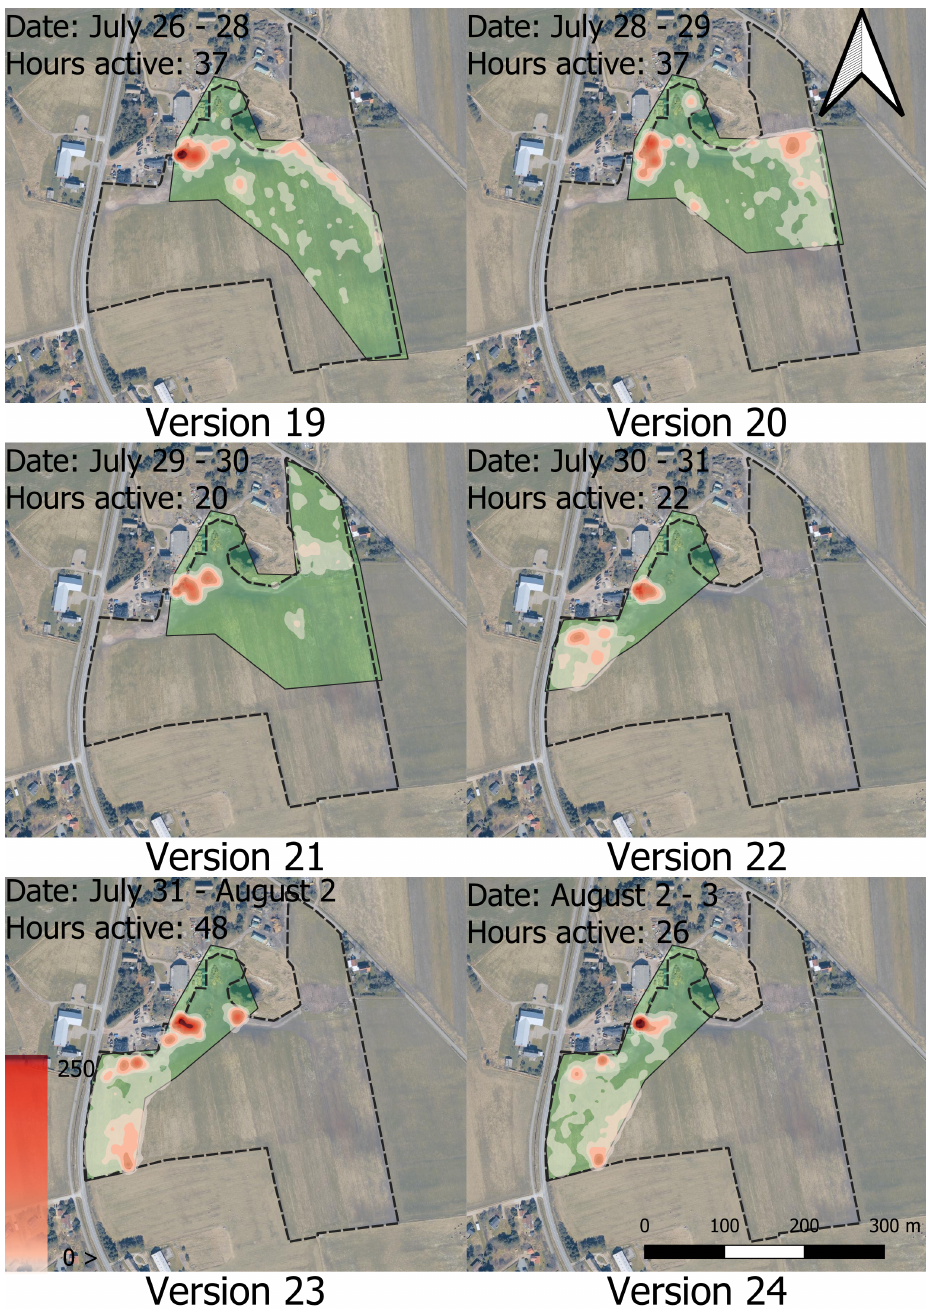
Figure A13. Heatmap series 4 visualising all Poll messages sent during the period from 26 July to 3 August. The green area shows the virtual enclosure area to which the bull calves were limited. The white to red colour indicates the number of Poll messages within a 10 m radius. The brightest colour represents the areas with the lowest density of Poll messages, while the darkest colour represents the areas with 250 or more Poll messages within the radius. The coordinates of the upper left corner of the map frame are 55°25 (cid:48) 23.131 (cid:48)(cid:48) E 8°23 (cid:48) 53.531 (cid:48)(cid:48) N. Contains data from the Agency for Data Supply and Infrastructure, Forårsbilleder Ortofoto-GeoDanmark, December